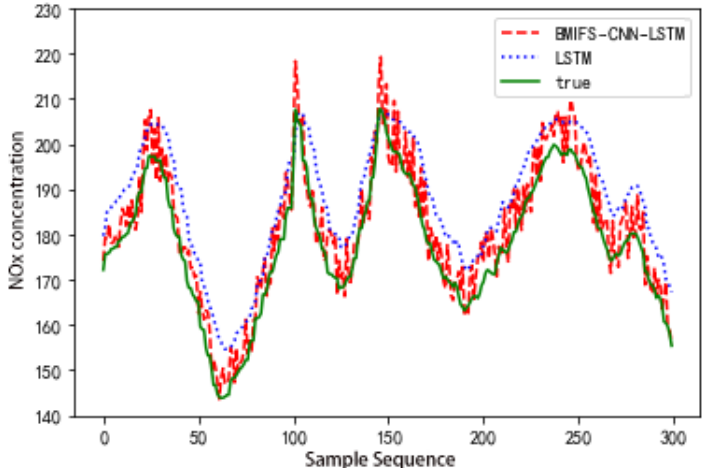
Figure 8. Comparison chart of estimated effect of test data.